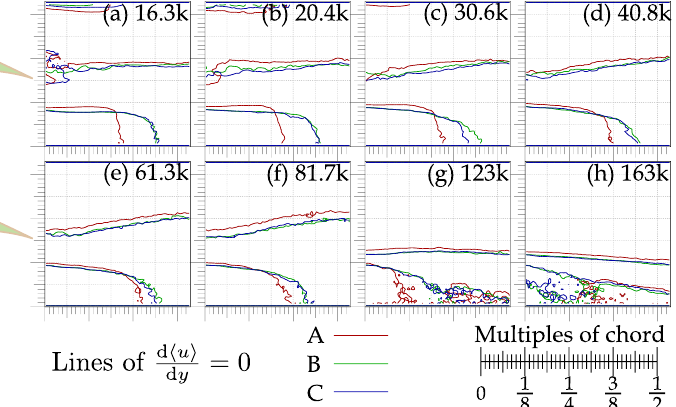
Figure A2. Lines of extrema of (cid:104) u (cid:105) in cross-stream direction ( y ) . The number in the top-right corner of each panel is the chord-based Reynolds number, and k denotes · 10 3 . Angle of attack α = 0 ◦ in all panels.